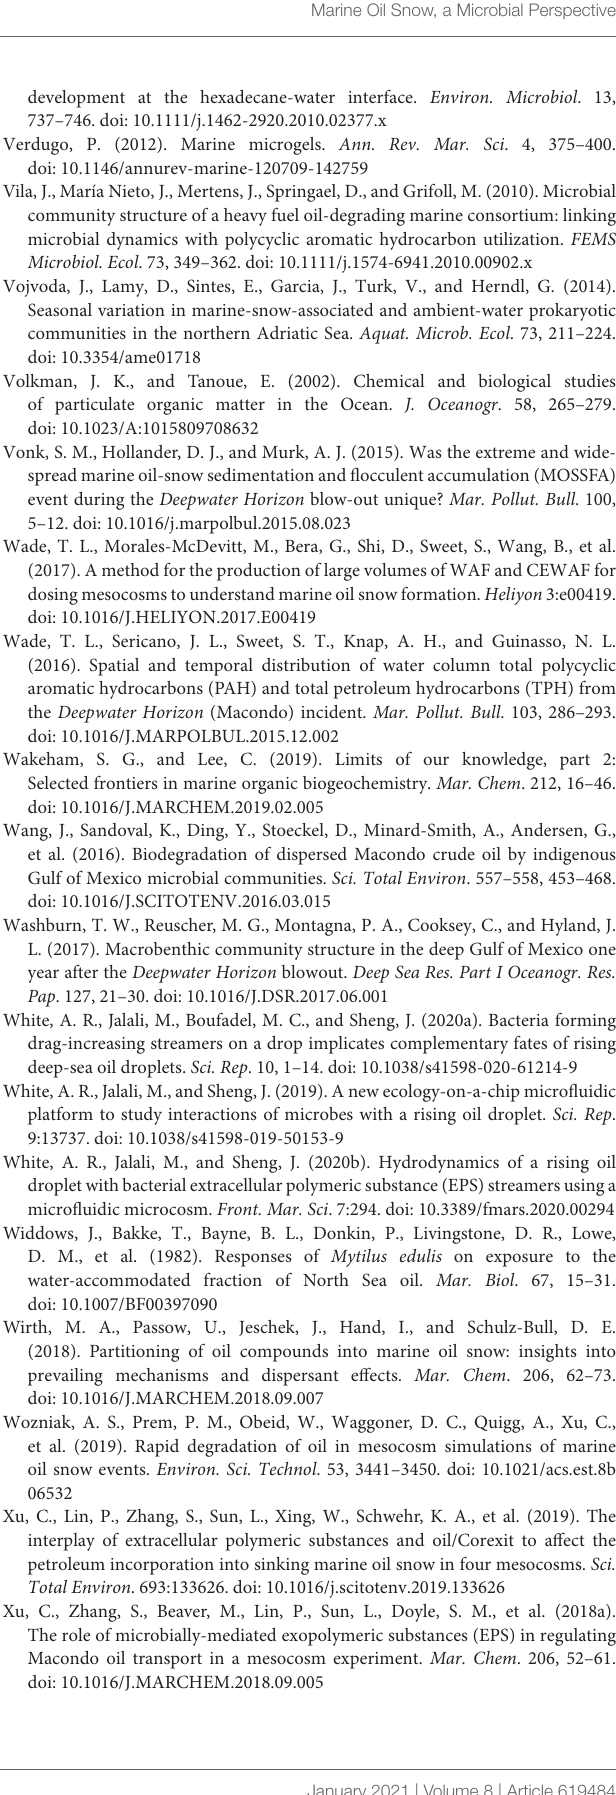
Figueiras, F. G. (2007). Dynamics of the hydrocarbon-degrading Cycloclasticus bacteria during mesocosm-simulated oil spills. Environ. Microbiol .